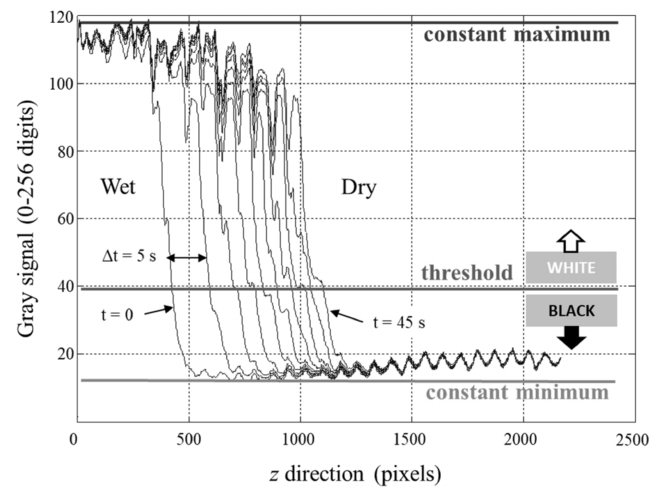
Figure 4. Graphical analysis of the gray signal from capillary rise images and selection of the threshold value for black and white conversion.